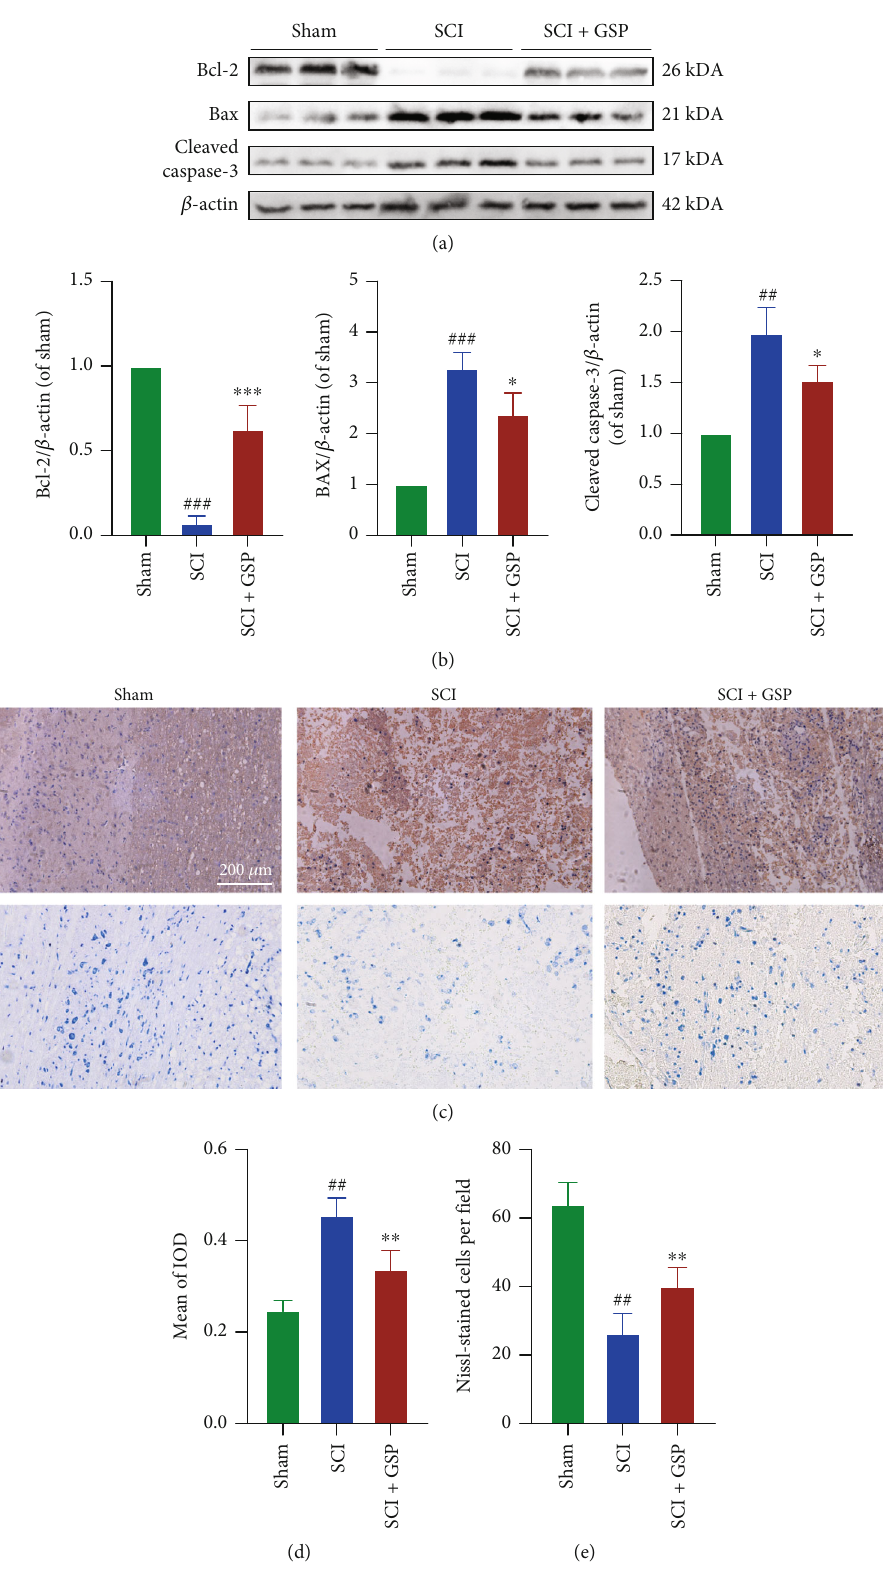
Figure 5: GSP inhibit apoptosis in vivo . (a, b) Representative WB and quantitative data of Bax, Bcl-2, and cleaved caspase-3 in the di ff erent groups at 14dpi ( n = 3 rats in each group). (c, d) Representative IHC staining and Nissl staining in the di ff erent groups at 14 dpi. (d) Quantitative data of cleaved caspase-3. ( n = 3 , with 5 images for each rat). (e) Quantitative data of the number of Nissl-stained cells at 14 days after SCI ( n = 3 rats in each group). ## p < 0 : 01 or ### p < 0 : 001 vs. sham group. ∗ p < 0 : 05 , ∗∗ p < 0 : 01 , or ∗∗∗ p < 0 : 001 vs. SCI